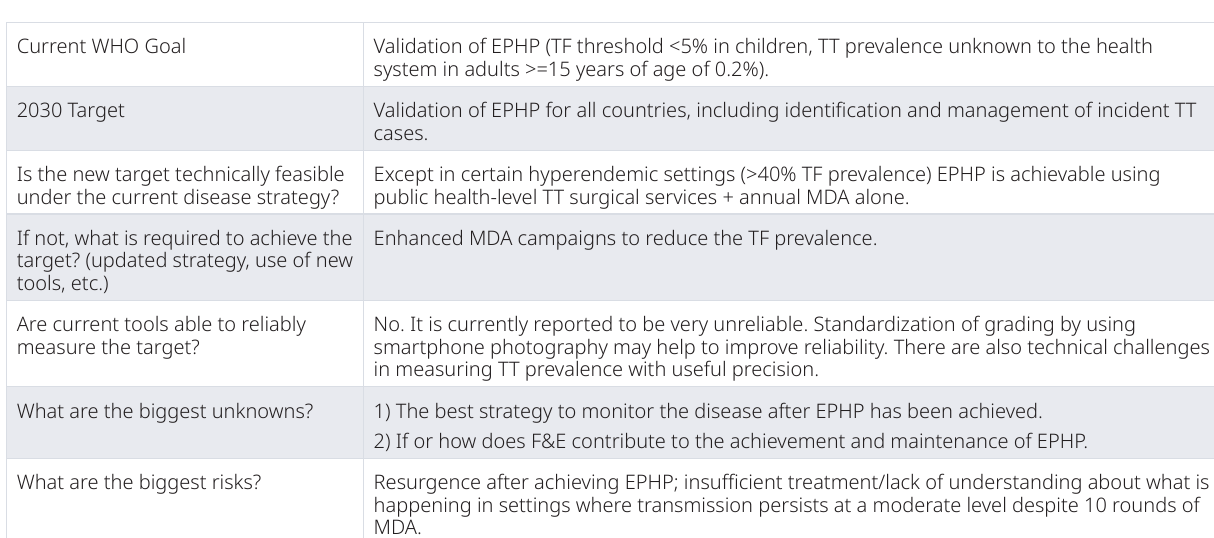
Table 1. Executive summary. Current WHO